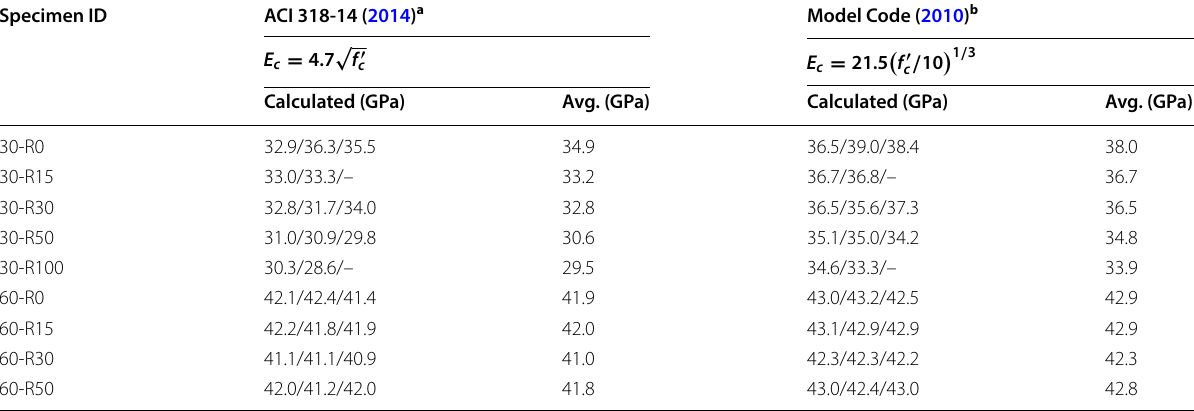
Table 10 Estimated elastic modulus using the code